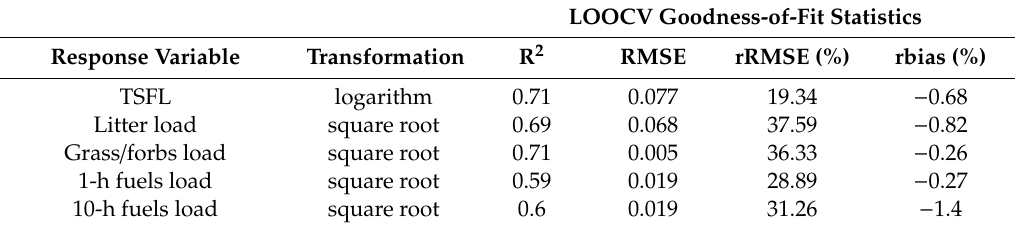
Table 6. The goodness-of-fit statistical measures obtained from the leave-one-out cross validation (LOOCV) process and employed transformations of the response variables in each developed regression model produced by the combined use of structural and intensity metrics for the estimation of the total and surface fuel types’ load (TSFL and SFTL, respectively). TSFL includes the load of all SFTs sampled in each plots (i.e., litter, grass and forbs, shrubs, regeneration, 1-h, 10-h, and 100-h fuels).